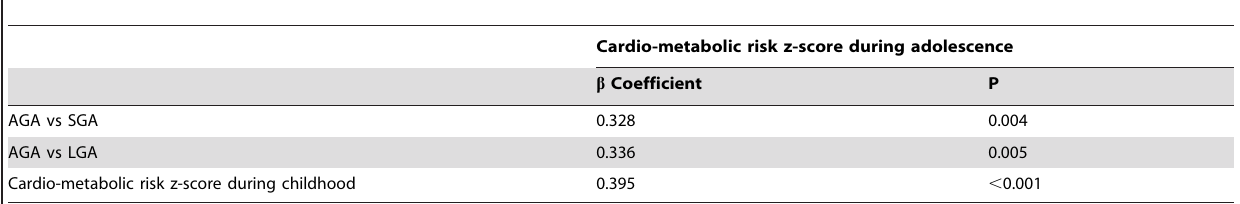
Table 3. Association between birth weight categories, the cardio-metabolic risk z-score during childhood and the cardio- metabolic risk z-score during